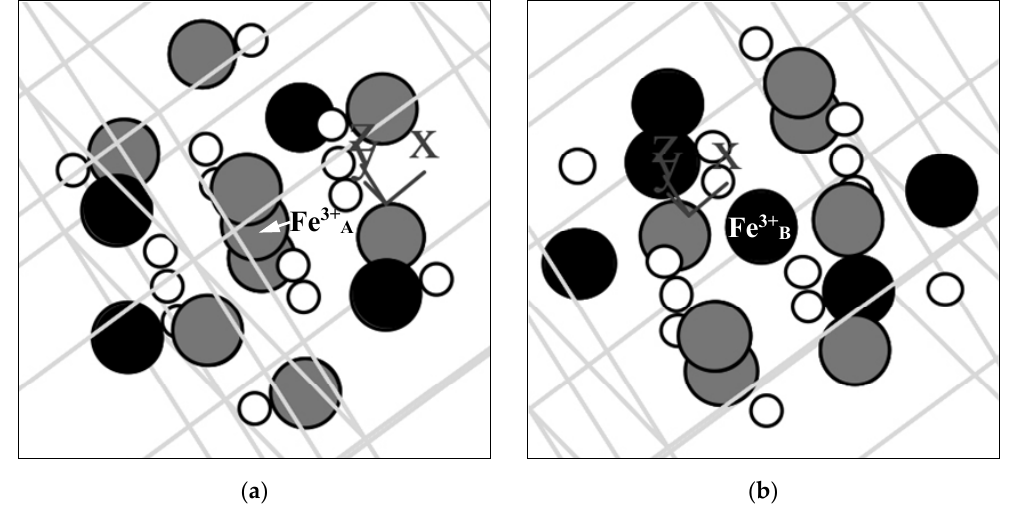
Figure 71. Local microenvironments of Fe 3+ cation in the (A) ( a ) and [B] ( b ) sites of the ideal MgFe 2 O 4 crystal: are the (A) sites, are the [B] sites, are O 2– ions. Adapted from Ref. [94] with permission from Elsevier: Journal of Alloys and Compounds, Vol. 912, Ushakov M.V., Nithya V.D., Rajeesh Kumar N.,